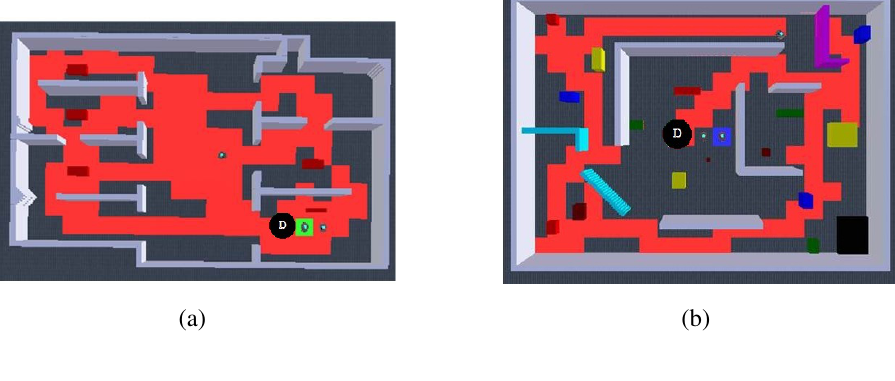
Figure 5. Typical navigation for qualitative appreciation: ( a ) The environment based upon Burgard’s work in [1]; ( b ) A second more cluttered environment. Snapshots are taken from the top view and the traversed paths are drawn in red. For both scenarios the robot efficiently traverses the complete area using the same algorithm. Black circle with D indicates deployment